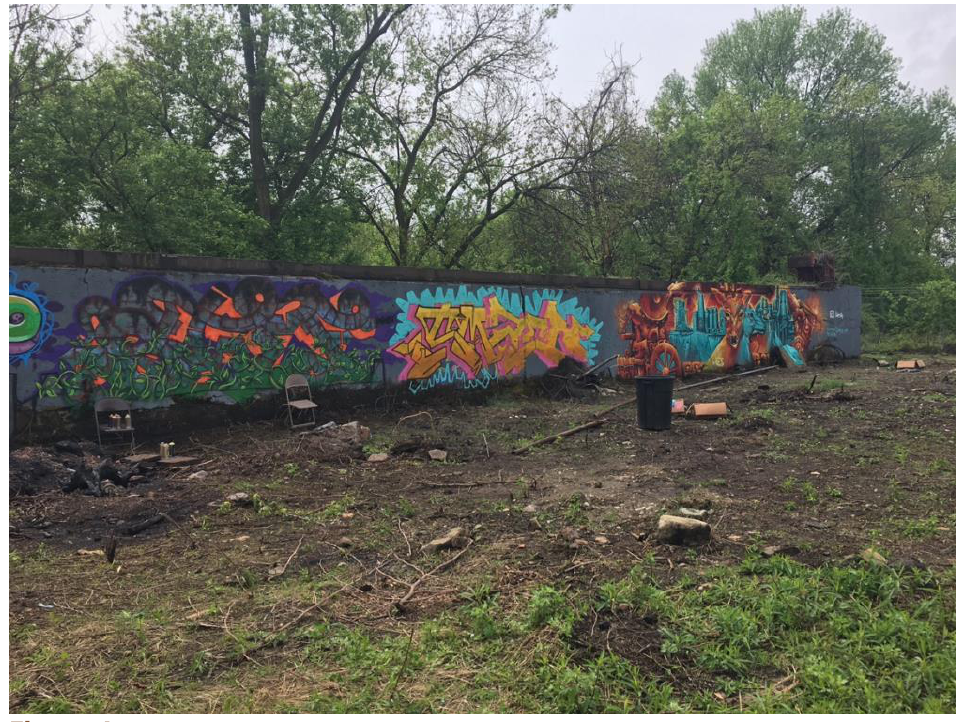
Caitlin Frances Bruce, Mural in Progress 2 , Aerosol paint on wall, 2017, Rankin, Pennsylvania.